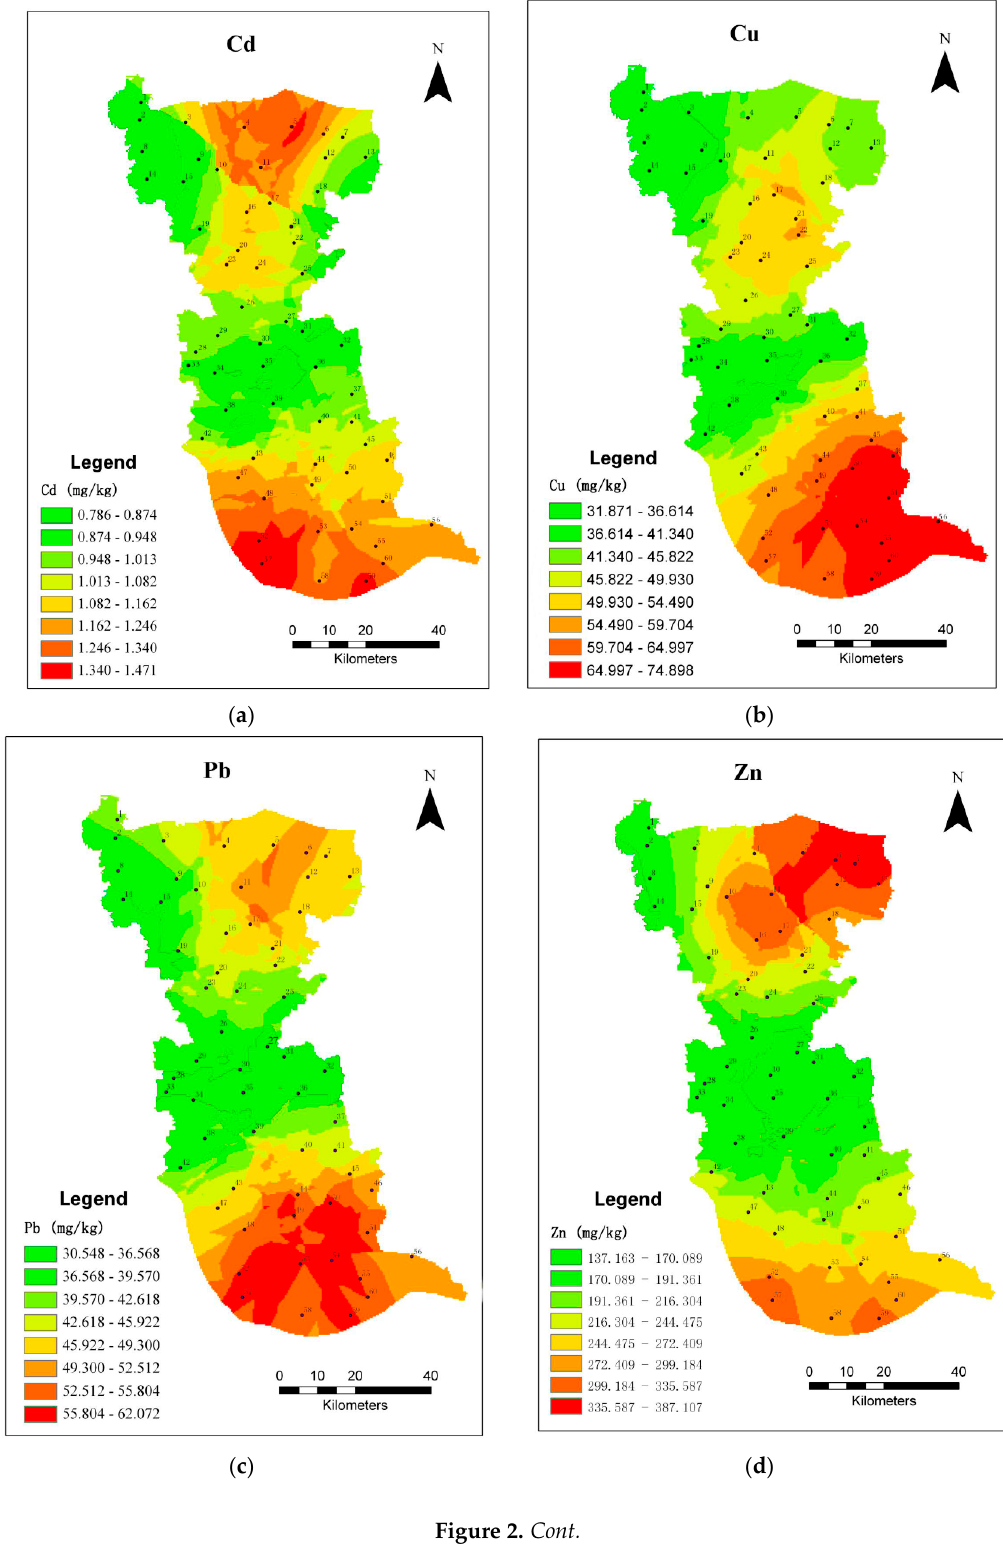
Figure 2 . Cont . Figure 2.